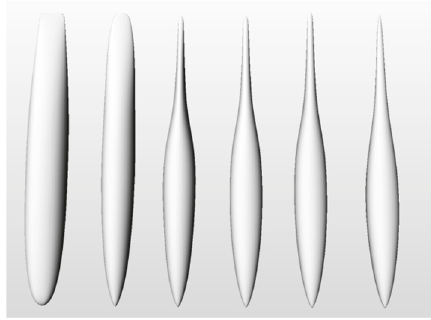
Figure 3: The optimization process of fuselage.